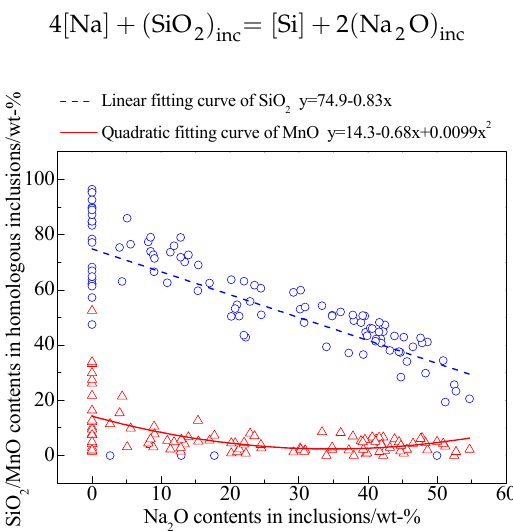
Linear fitting curve of SiO